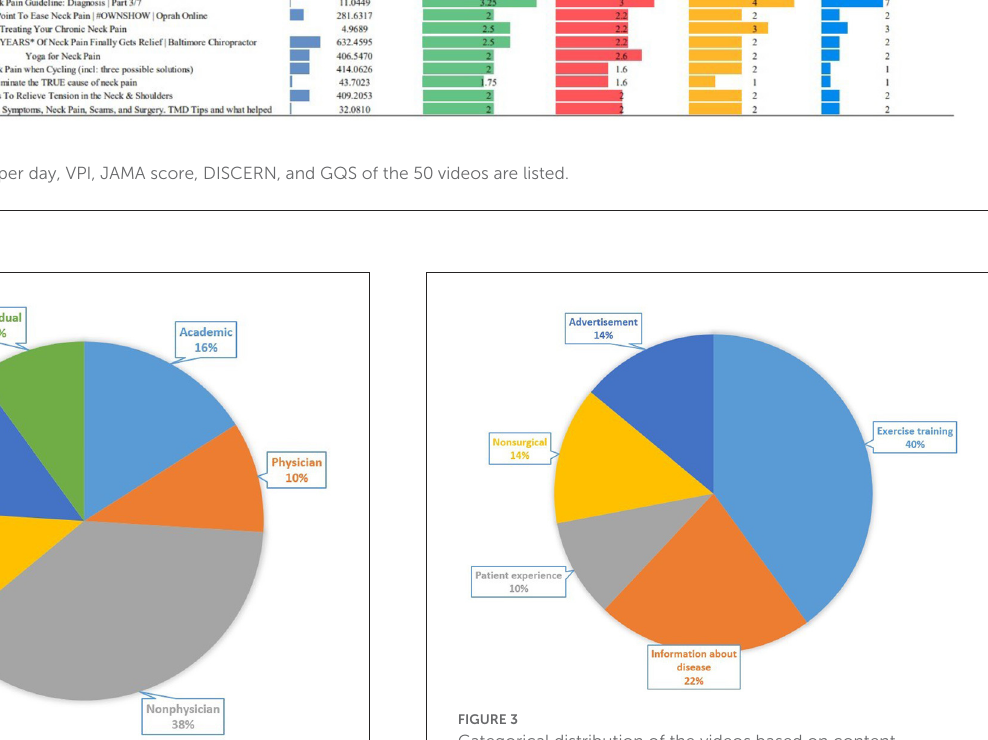
GQS ( P = 0.001), and NPSS ( P = 0.007), with videos from the academic group having the highest VPI, JAMA score, DISCERN, GQS, and NPSS. However, the VPI ( P = 0.395), JAMA ( P = 0.564), DISCERN ( P = 0.869), GQS ( P = 0.467), and NPSS ( P = 0.329) did not statistically differ between the groups based on video content (Table